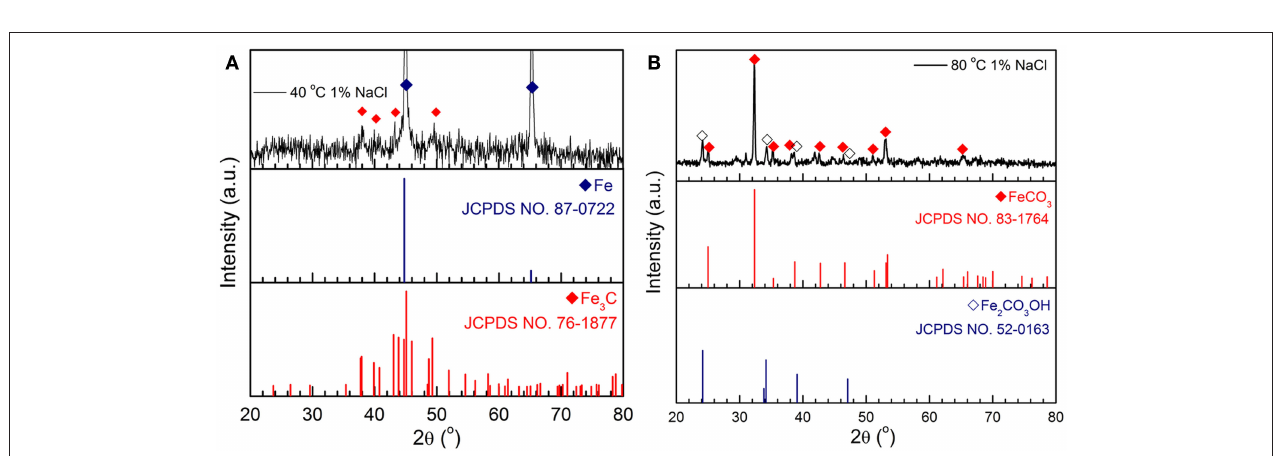
FIGURE 6 | XRD patterns of the corrosion products formed on C1018 steel after 100h in 1% NaCl at (A) 40 and (B) 80 ◦ C.